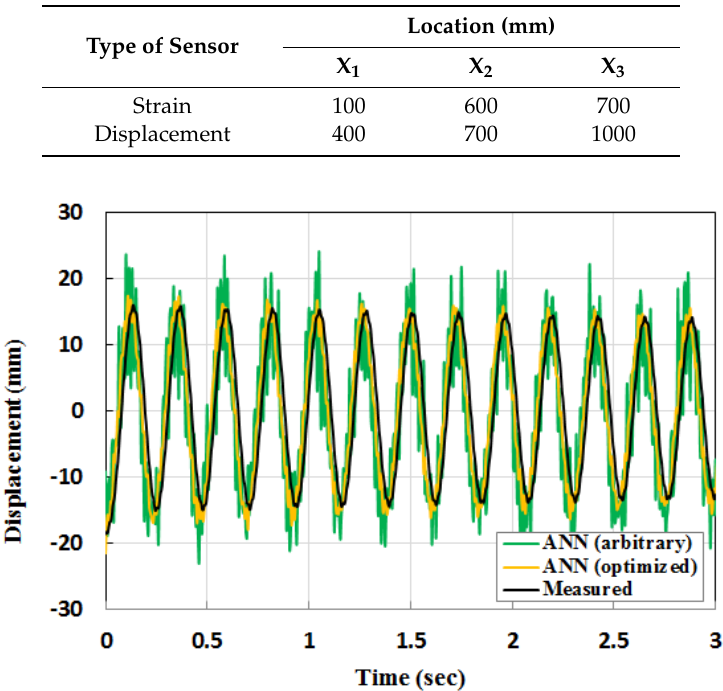
Figure 20. Displacements over time at x = 1000 mm.